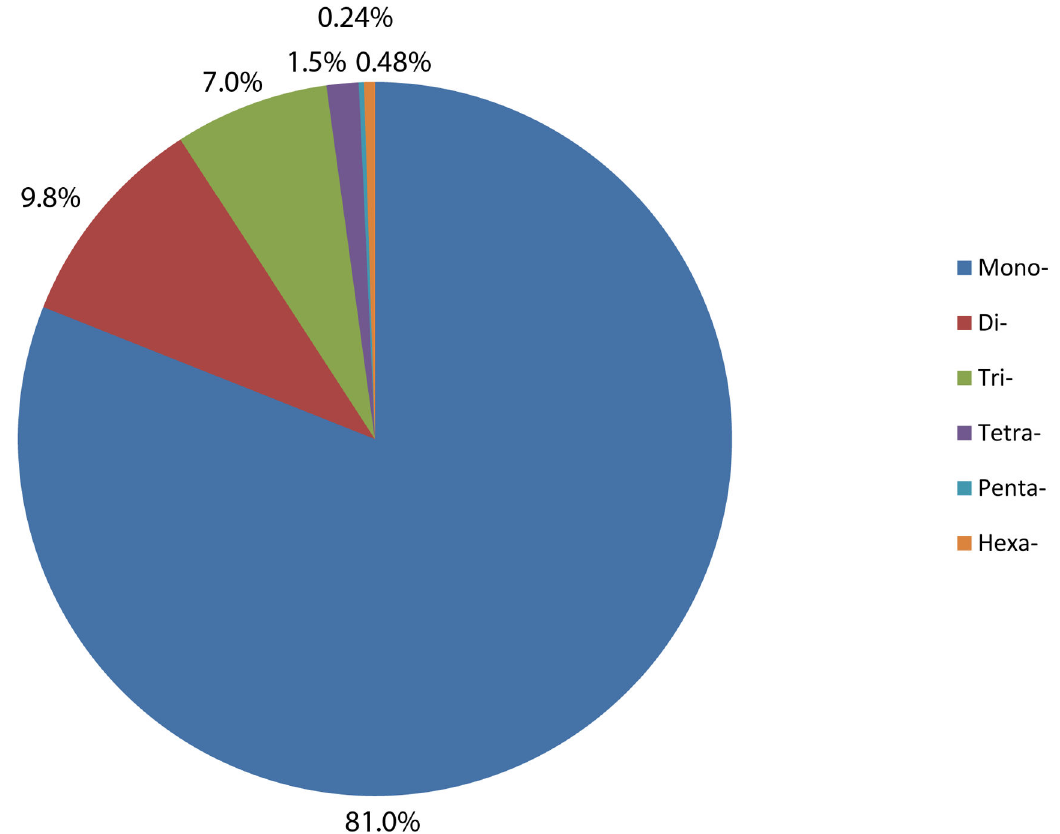
Figure 2. Frequency distribution of microsatellite loci in Anisogramma anomala by motif length. doi: